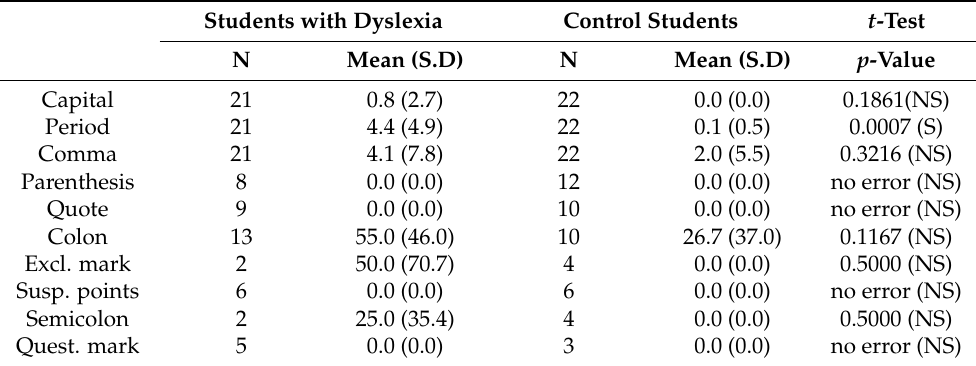
Table 8. Confusion rates for each punctuation category (mean, SD, and Welch p -value: NS = non significant/S = significant).